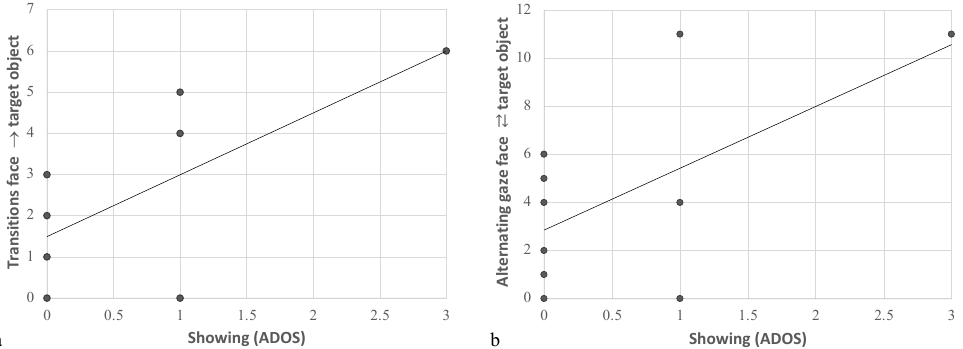
Figure 3. Correlation between Showing and ( a ) transitions from face to target object and ( b ) alternat- ing gaze between face and target object in HR-noASD population